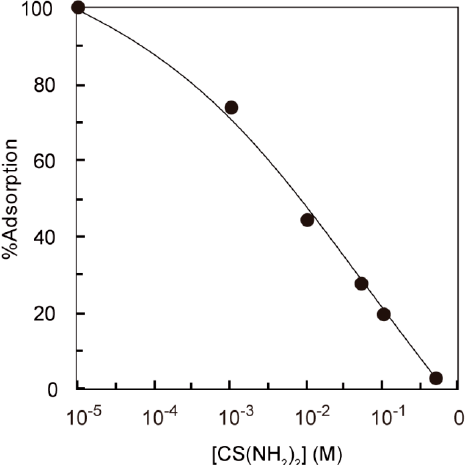
Figure 3. Effect of thiourea concentration on the adsorption of Ag(I) on the PEI-MAR. Conditions: Ag(I) concentration = 0.2 mM, weight of adsorbent = 10 mg, H 2 SO 4 concentration = 0.05 M, volume of test solution = 10 mL, temperature = 30 °C, and shaking time = 24 h. Materials 2017 , 10 , 636